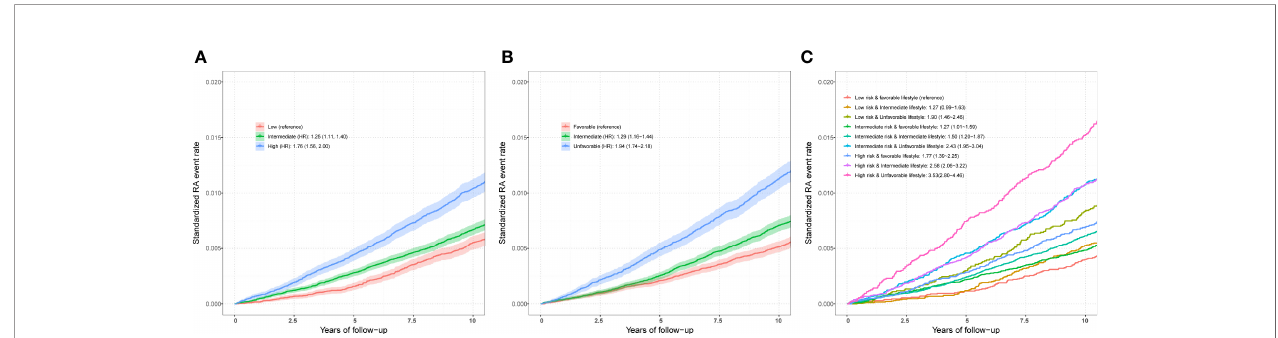
FIGURE 3 | (A) Standardized rates of RA events in low (bottom quartile), intermediate (quartiles 2 to 3), and high (top quartile) genetic risk groups in the UKB cohort. (B) Standardized rates of RA events in favorable, intermediate, and unfavorable lifestyle groups in the UKB cohort (C) Standardized rates of RA events in participates with different genetic risk score groups and different lifestyle groups in the UKB cohort. Associations were adjusted for age, sex, genotyped batch, assessment center, TDI, and the fi rst 10 principal components of ancestry. RA, rheumatoid arthritis; PRS, polygenic risk score; MHC, major histocompatibility complex; OR, odds ratio; HR, hazard ratio. De fi nition of healthy lifestyle indicators: include 0 to 1 healthy lifestyle indicator for unfavorable lifestyle, 2 for moderate lifestyle, and all 3 for favorable lifestyle. The genetic risk groups were evaluated by PRS: low genetic risk (bottom quartile of PRS), intermediate genetic risk (quartiles 2 to 3), and high genetic risk (top